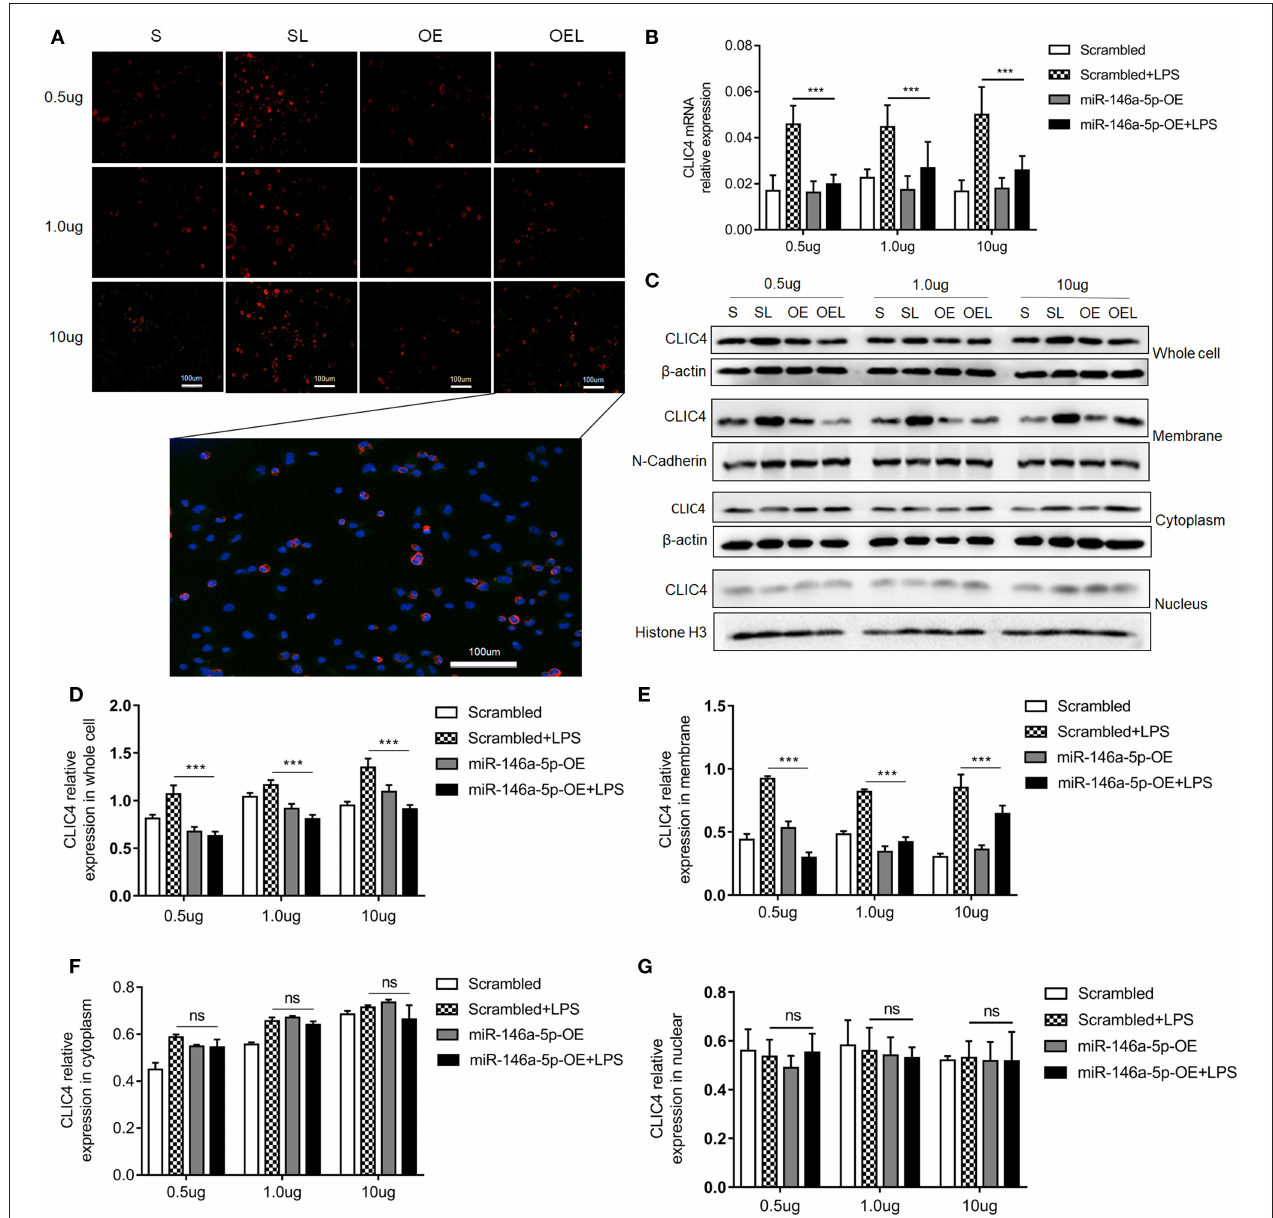
FIGURE 6 | CLIC4 expression level in macrophage subcellular fraction after miR-146a-5p overexpression sequence pre-incubation followed by LPS/ATP stimulation. (A) Immunofluorescence showing the CLIC4 expression level after miR-146a-5p overexpression sequence pre-incubation followed by 0.5 µ g/ml LPS + 5mM ATP, 1.0 µ g/ml LPS + 5mM ATP, or 10 µ g/ml LPS + 5mM ATP stimulation. The representative merged picture of CLC4 and DAPI is shown at the bottom of panel A. (B) CLIC4 mRNA expression level after miR-146a-5p overexpression sequence pre-incubation followed by 0.5 µ g/ml LPS + 5mM ATP, 1.0 µ g/ml LPS + 5mM ATP, or 10 µ g/ml LPS + 5mM ATP stimulation ( n = 6 per group). (C) CLIC4 protein expression levels in the whole cell, membrane, cytoplasm, and nucleus of macrophage after miR-146a-5p overexpression sequence pre-incubation followed by 0.5 µ g/ml LPS + 5mM ATP, 1.0 µ g/ml LPS + 5mM ATP, or 10 µ g/ml LPS + 5mM ATP stimulation. (D–G) The statistics of CLIC4 protein levels of (C) the whole cell, membrane, cytoplasm, and nucleus of macrophage ( n = 4 per group). Scrambled (S), miR-146a-5p scrambled sequence; Scrambled + LPS (SL), miR-146a-5p scrambled sequence + LPS; miR-146a-5p-OE (OE), miR-146a-5p overexpression sequence; miR-146a-5p-OE + LPS (OEL), miR-146a-5p overexpression sequence + LPS. *** P < 0.001. ns, no statistical